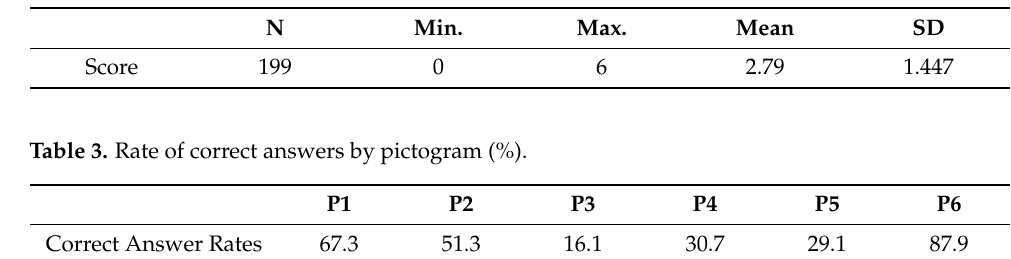
Table 2. Scores for the understanding level.